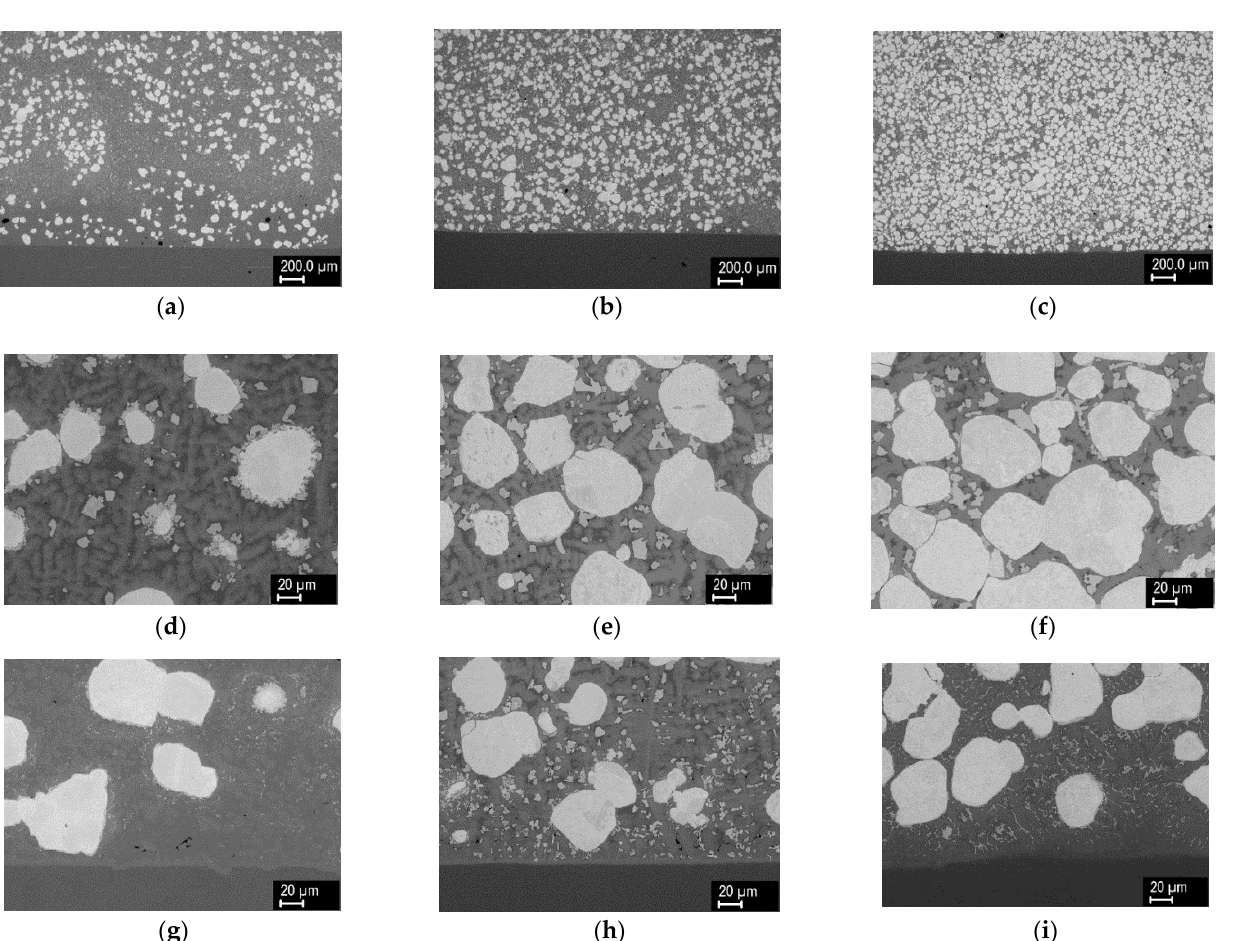
Figure 2. Cross sections of W–Ni claddings made from 25%, 50%, and 75% W mixtures (left, center, and right columns, respectively): ( a – c ) overview, ( d – f ) detail from the middle, ( g – i ) detail near the substrate. In this and the following figures, the substrate is the homogeneous region at the bottom of the respective images, free from tungsten grains (which is the lighter phase).